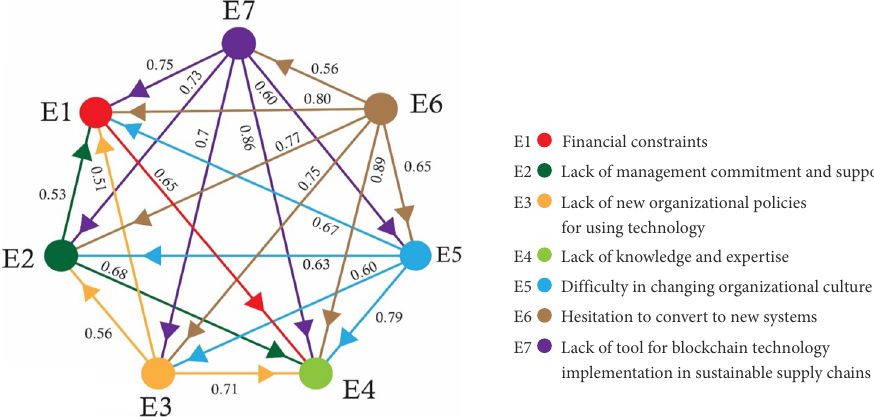
Figure 8. The visualization of the credal ranking for intra-organizational